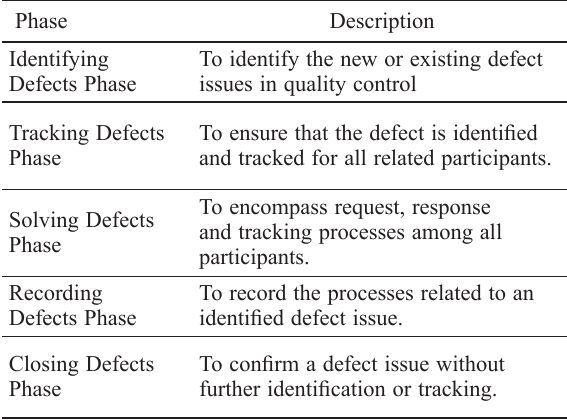
Table 1. Description of construction DM